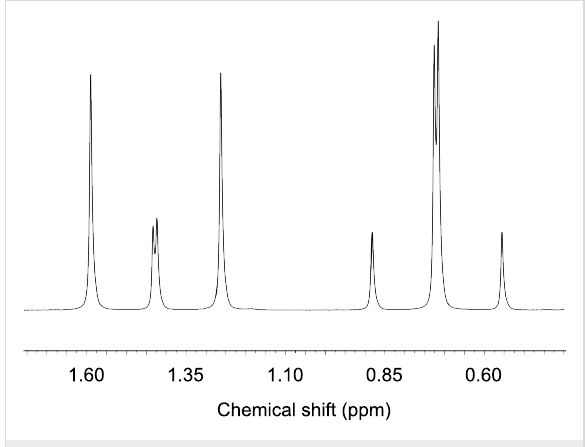
Figure 4: Portion of 1 H NMR spectrum of 8 showing greater 1 J HC coupling in the less shielded methyl group.